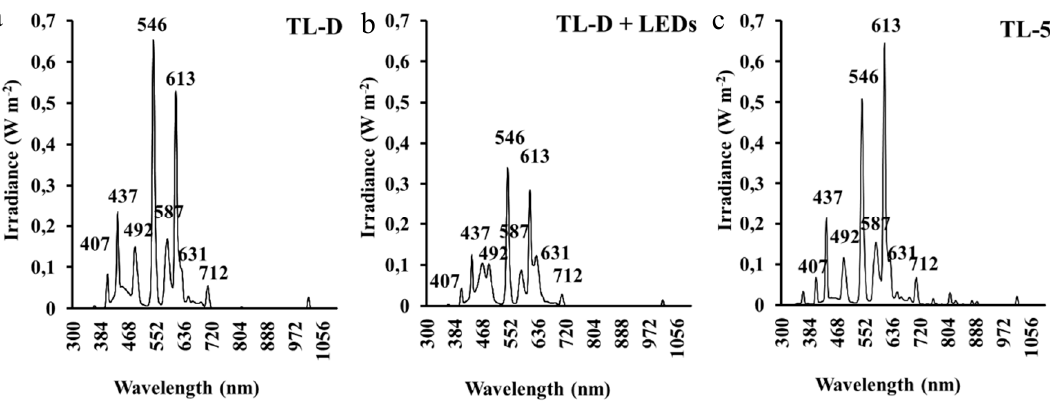
Figure 1. Spectral distribution of the different light treatments: ( a ) TL-D, ( b ) TL-D+LEDs and ( c ) TL- 5. Table 1. Agronomic characterization of light treatments.